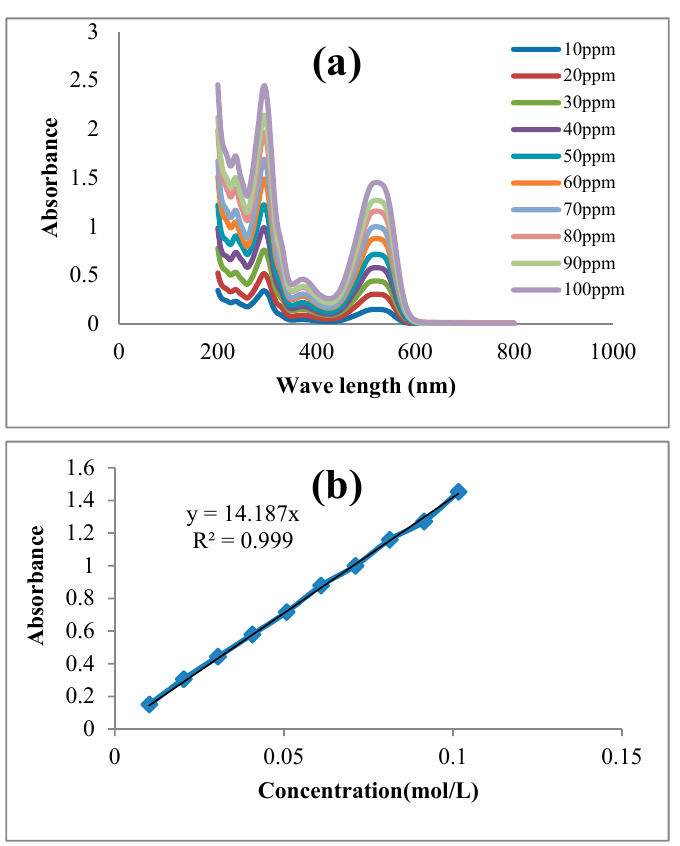
Figure 2. ( a ) The absorption of synthetic wastewater in various dye concentrations from 10 to 100 ppm between wavelengths of 200 and 800 µm, and ( b ) the relation between adsorption and the dye concentration.